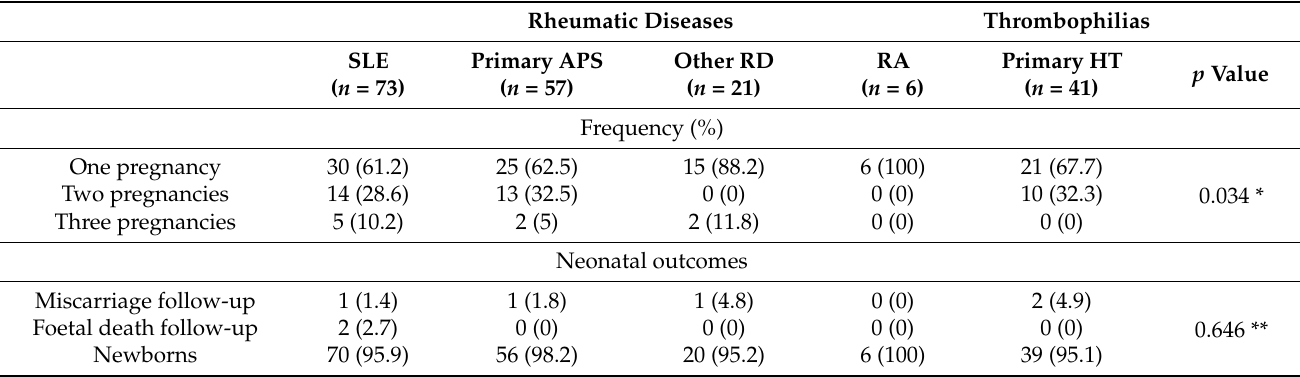
Table 4. Pregnancy episodes in women followed at the MC by pathology.